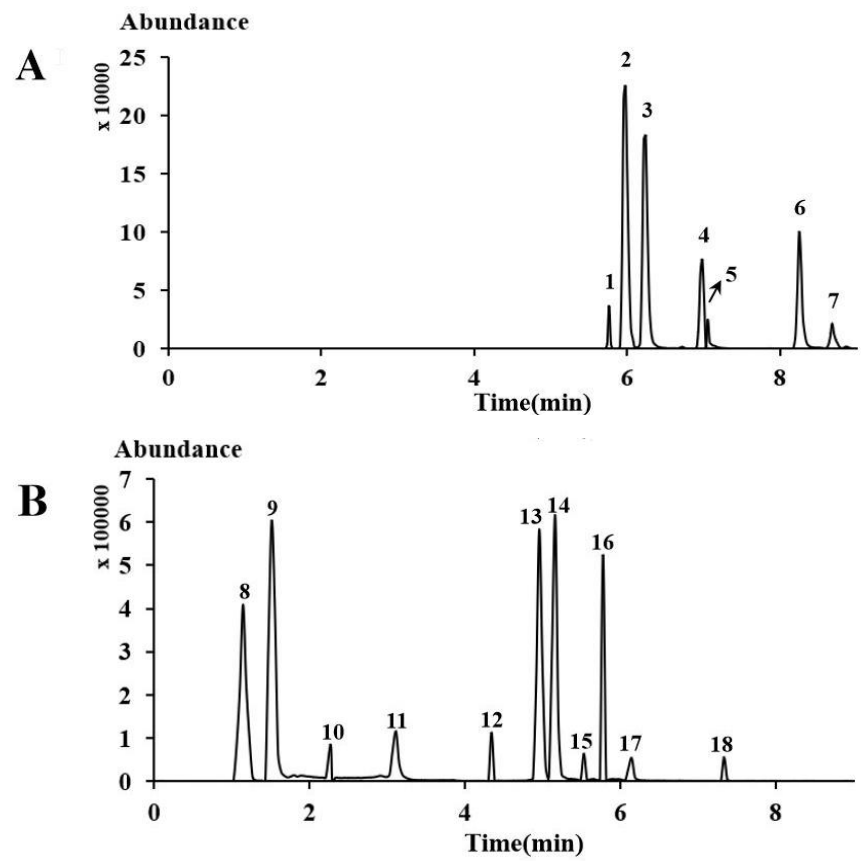
Figure 2. Multiple reaction monitoring (MRM) total ion chromatograms of 18 reference standards in ( A ) positive mode and ( B ) negative mode.